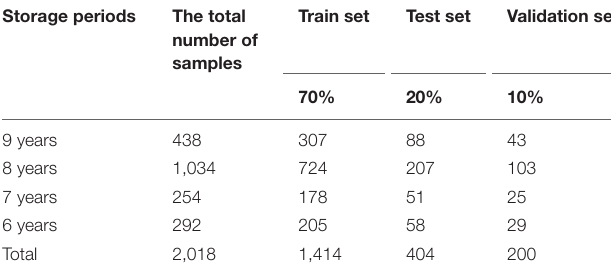
TABLE 1 | The details of data set partitioning.